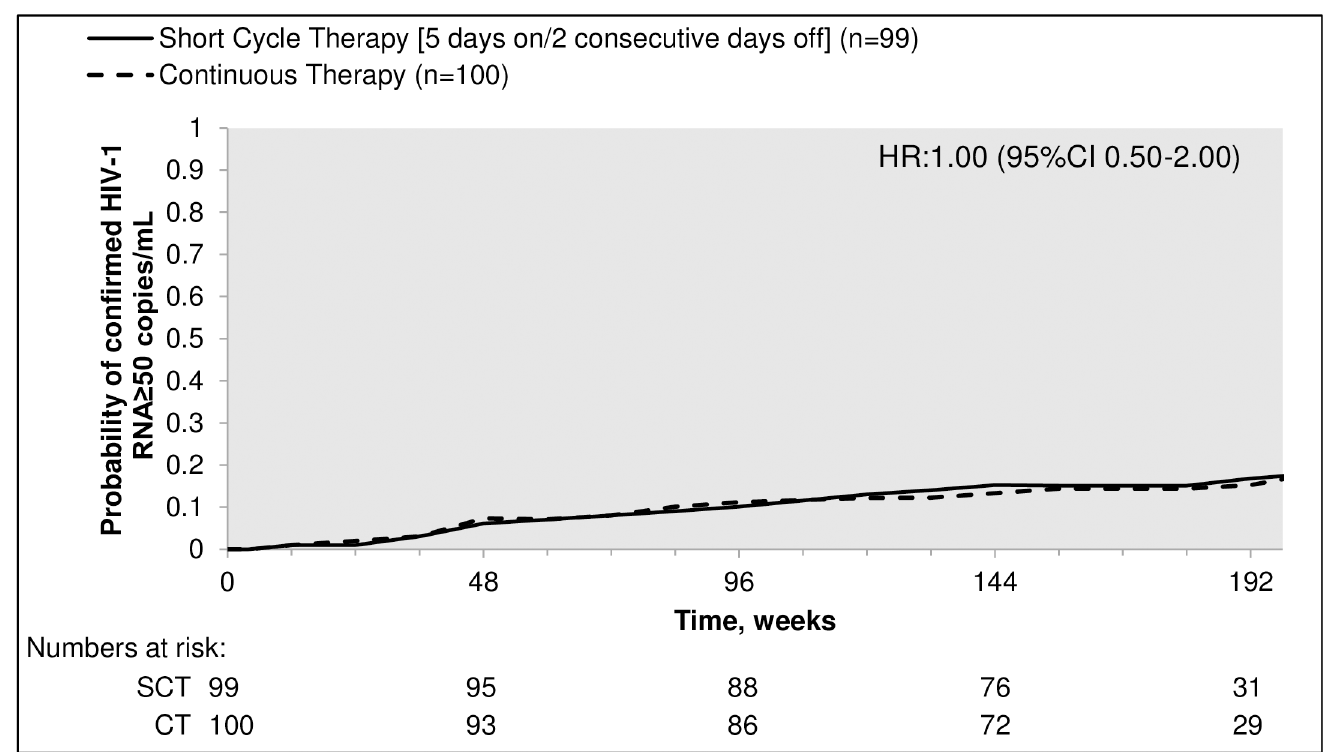
Fig 2. Time to confirmed HIV-1 RNA (cid:21) 50 copies/mL in the intent-to-treat analysis (adjusted Kaplan-Meier). SCT = short cycle therapy, CT = continuous therapy, HR = adjusted hazard ratio.